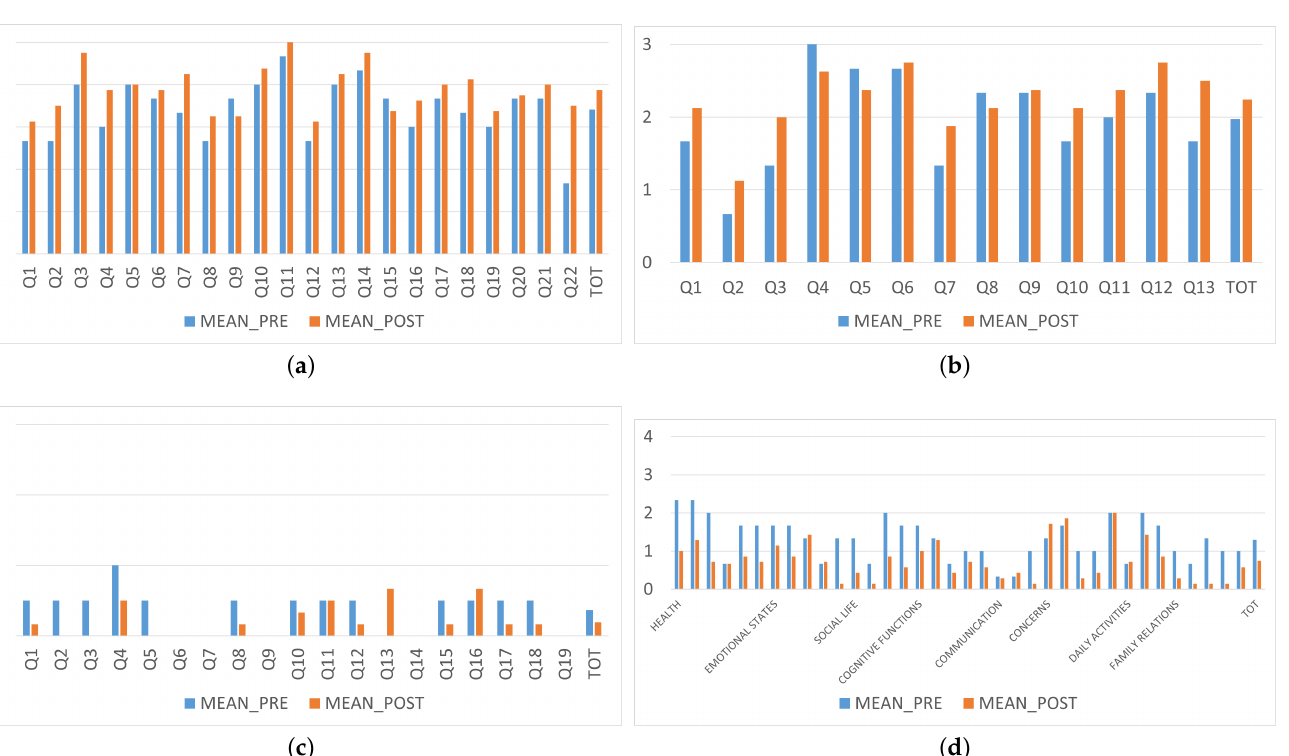
Figure 8. Mean results of the questionnaires provided to the users pre- and post-telemonitoring: ( a ) PGWBI, composed of 22 questions on well-being, with score from 0 (low) to 5 (high); ( b ) PSQI, composed of 13 questions on sleep quality, with score from 0 (bad) to 3 (good); ( c ) BDI, composed of 19 questions on depression, with score from 0 (good) to 3 (depressed); ( d ) PedsQL, composed of 36 questions regarding different fields of babies QoL, with score from 0 (no problems) to 4 (always a